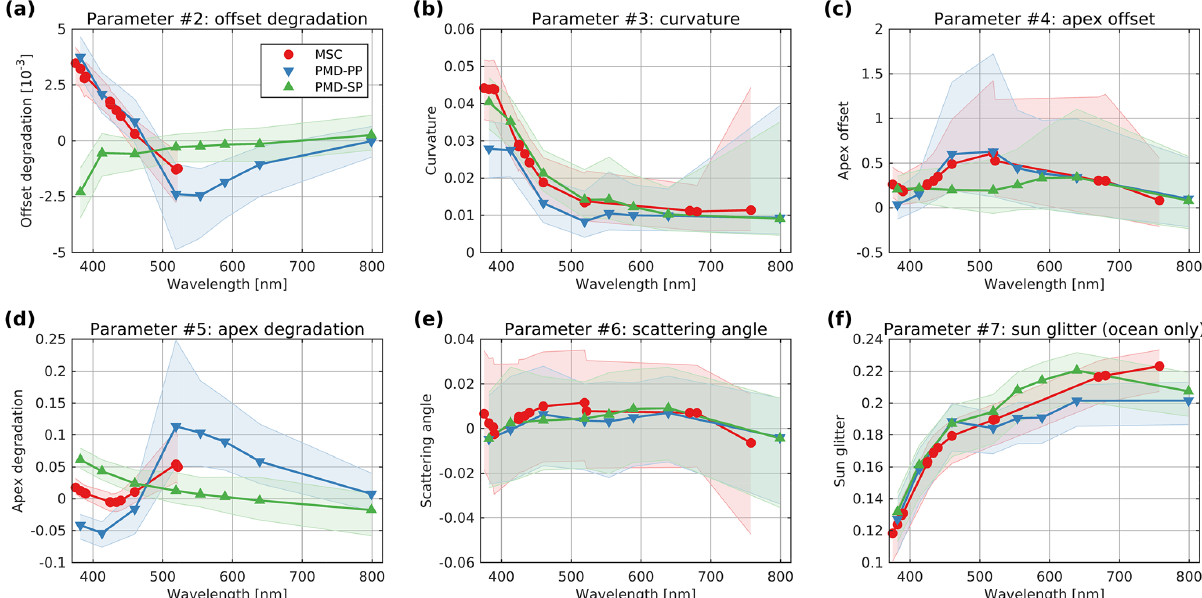
Figure D1. Wavelength dependency of T min parameters: (a) offset degradation, (b) curvature, (c) apex offset, (d) apex degradation, (e) scat- tering angle, and (f) sun glitter. MSC channels are in red, PMD channels 1–8 in blue, and PMD channels 9–16 in green. Interconnected data points are median fit parameters. Transparent areas include 50% of all results with boundaries at the 25th and 75th